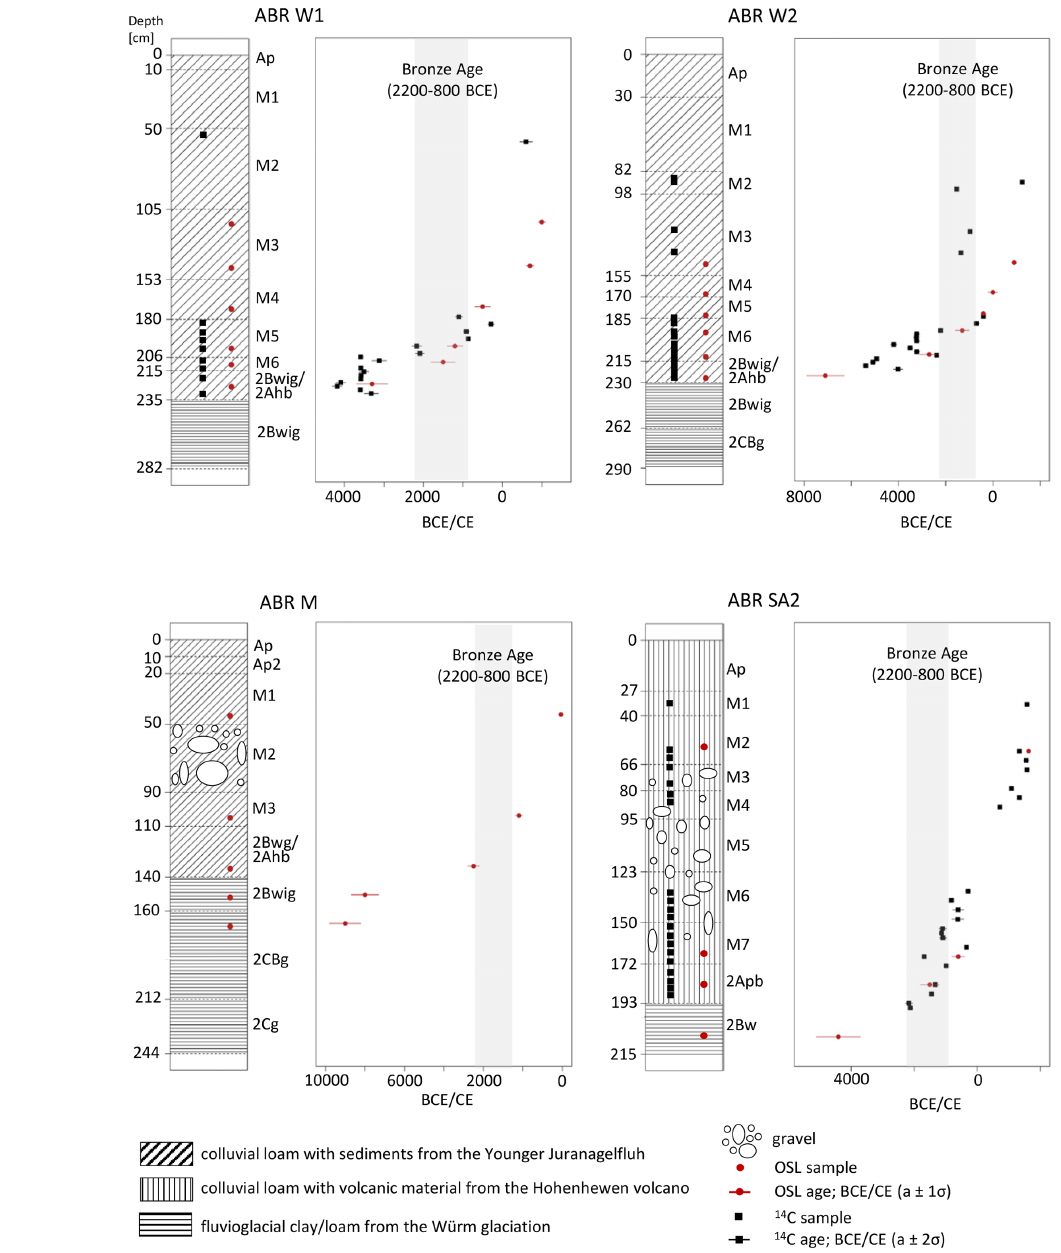
Figure 4. Colluvial profiles used for OSL and 14 C dating. Colluvial horizons are designated as M .